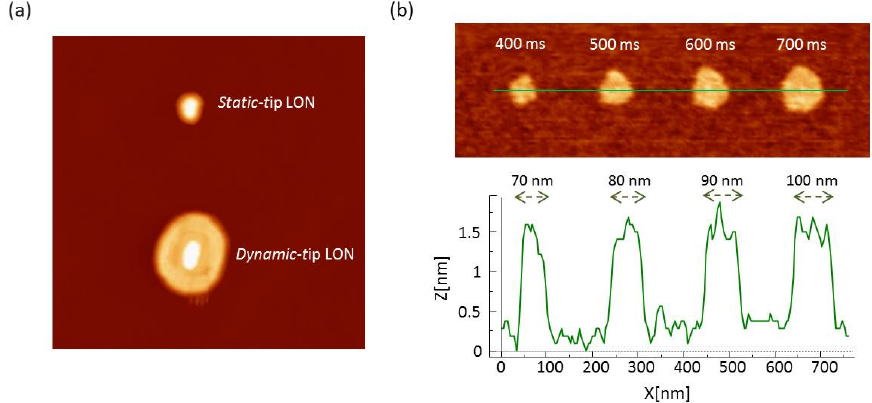
Figure 3. ( a ) Topography image of two dots performed by static-tip LON (top) and dynamic-tip LON (bottom) at the same oxide conditions: d ts = 15 nm, V ox = − 35 V, t ox = 100 ms. Image size: 2.9 µ m × 2.9 µ m; ( b ) Topography AFM image of an array of oxide dots performed with static-tip LON at a constant voltage value of − 42 V and with increasing pulse durations (dwell time step increment is 100 ms). Height profile measured along the line in ( b ). Image size: 900 nm × 300 nm. Appl. Sci. 2016 , 6 , 250